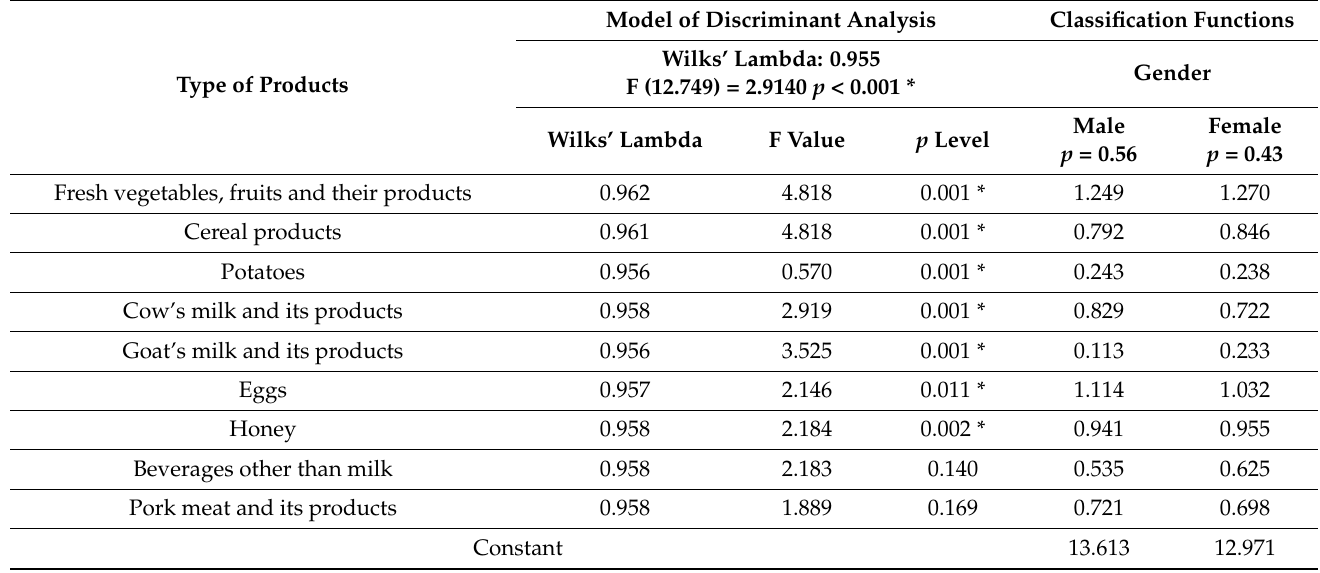
Table 5. Types of organic products selected for